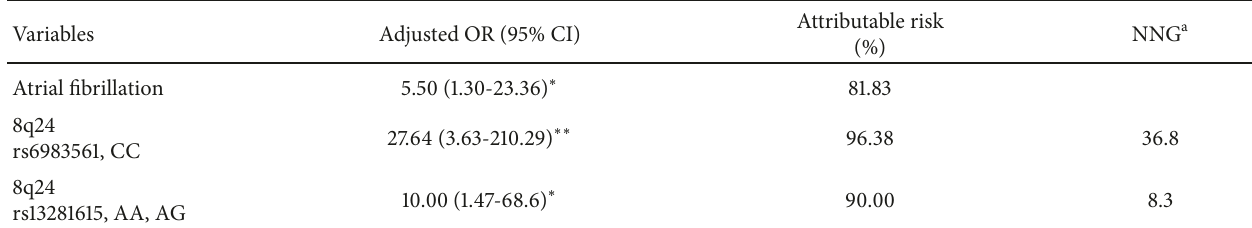
Table 3: Multivariate analysis to identify predictors for bleeding complications at a therapeutic